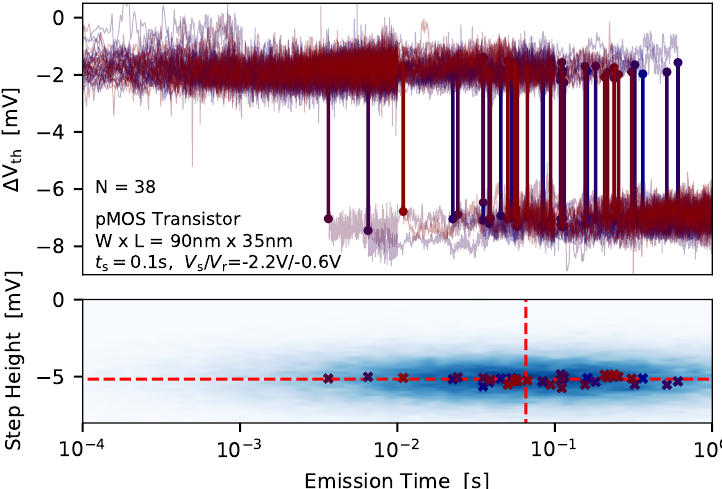
To extract the average charge capture time of a defect at a certain recovery bias the MSM sequence from Figure 2 (right) is applied, and N cycles at the same biases, temperature and stress/recovery times are measured. ( top ) The discrete steps in each recovery trace are extracted and binned into a ( bottom ) 2D histogram, which is called spectral map. In case that a number of emission events from a certain defect is available, a cluster is formed in the spectral map. Each of the clusters can be considered the finger print of a defect. The dashed lines in the spectral map indicate the average emission time, and the average step height, of the